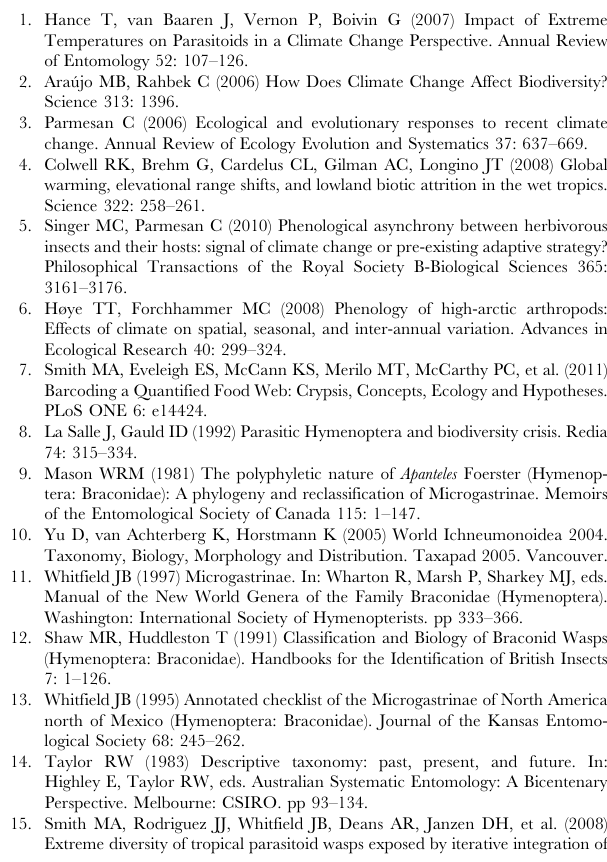
Table S3 Taxonomic commentary and context for selected species of Microgastrinae from Churchill, Manitoba, Canada. Table S4 Morphological characters used to study the species of Microgastrine from Churchill, Manitoba, Canada; and